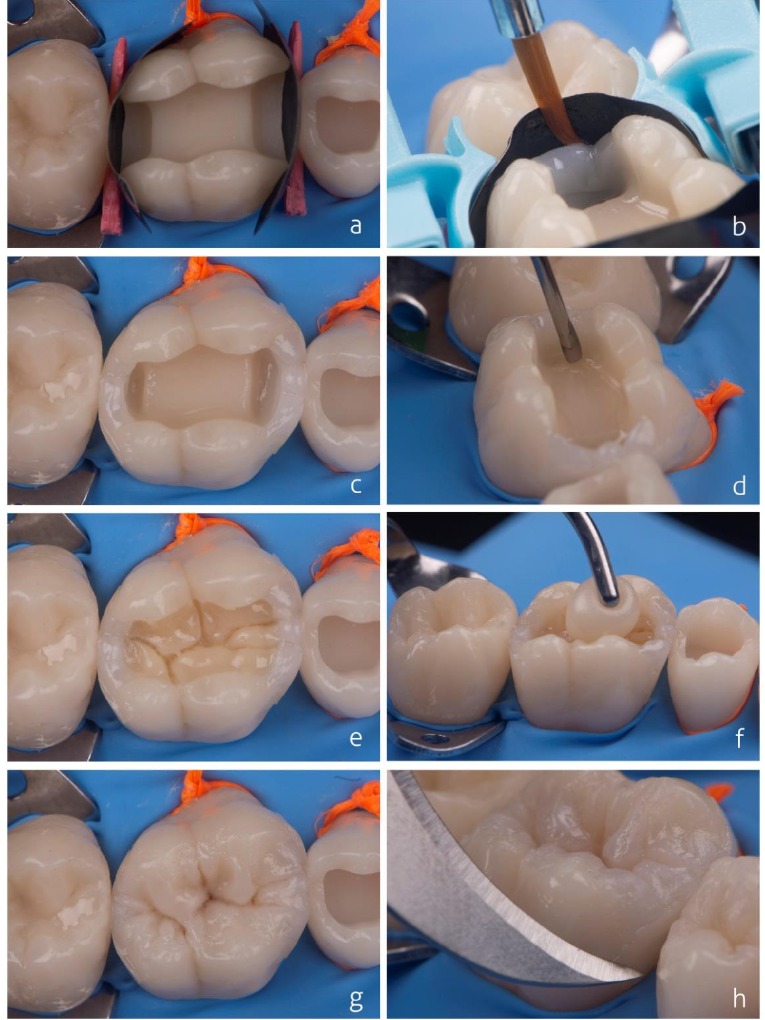
Figure 6. Class II restoration with composite. Positioning of partial matrices and wedges before application of adhesive system ( a ). Composite is placed in the proximal area and pre-polished with a brush before photoactivation ( b ). Aspect of the cavity with both proximal walls built with enamel composite ( c ). Proximal box filled with flowable bulk-fill composite ( d ). Restoration of artificial dentin and occlusal map design ( e ). Insertion of enamel composite on the occlusal surface ( f ). Aspect of the final occlusal anatomy ( g ) and finishing of proximal surfaces with scalpel blade ( h ).